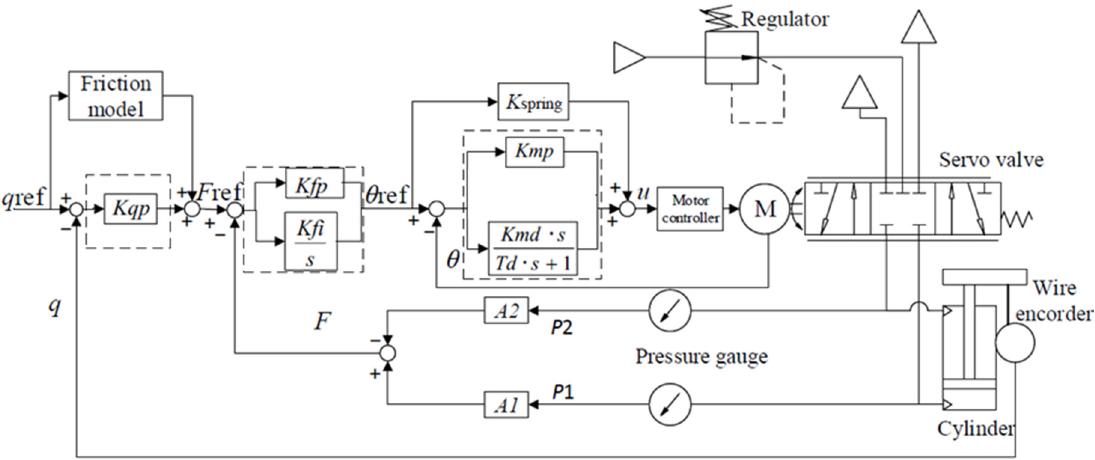
Table 2. Gain parameters of position control of a pneumatic cylinder.